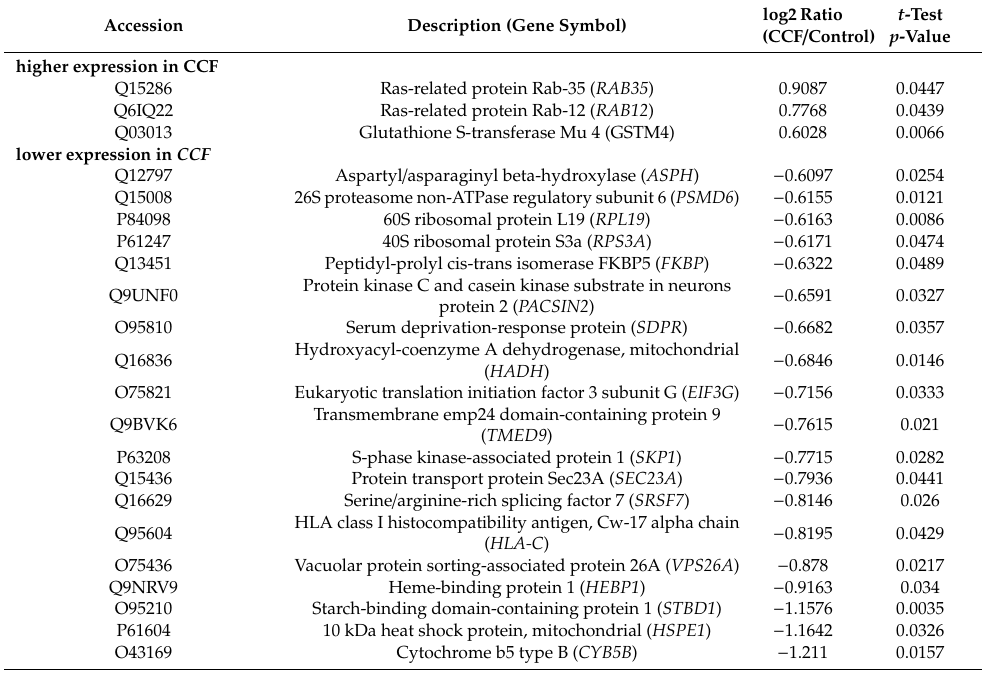
Table 2. Proteins with statistically significant di ff erential expression in CCF vs. control tissue (Student’s t -test, N =